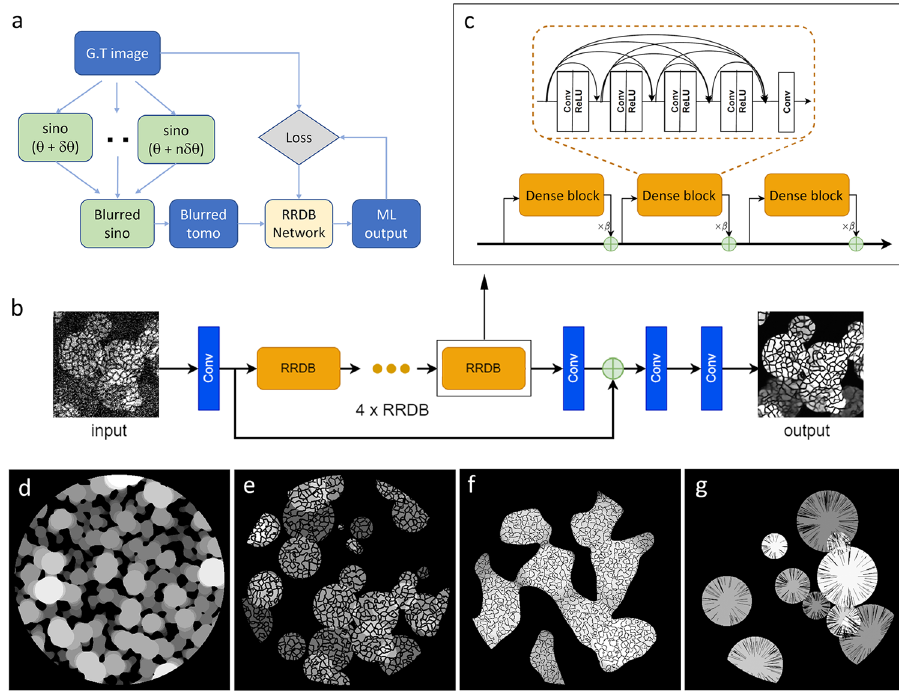
Fig. 2 Machine learning for tomography reconstruction. a Work fl ow. Blurred sinogram is calculated from the synthetic ground truth image (GT image) using Eq. (5). b Scheme of RRDB network containing four sequentially connected RRDB models. c Scheme of individual RRDB model (as outlined by the black rectangle in ( b ) containing three dense blocks. d – g Four types of synthetic images with coarse-to- fi ne features are used in model